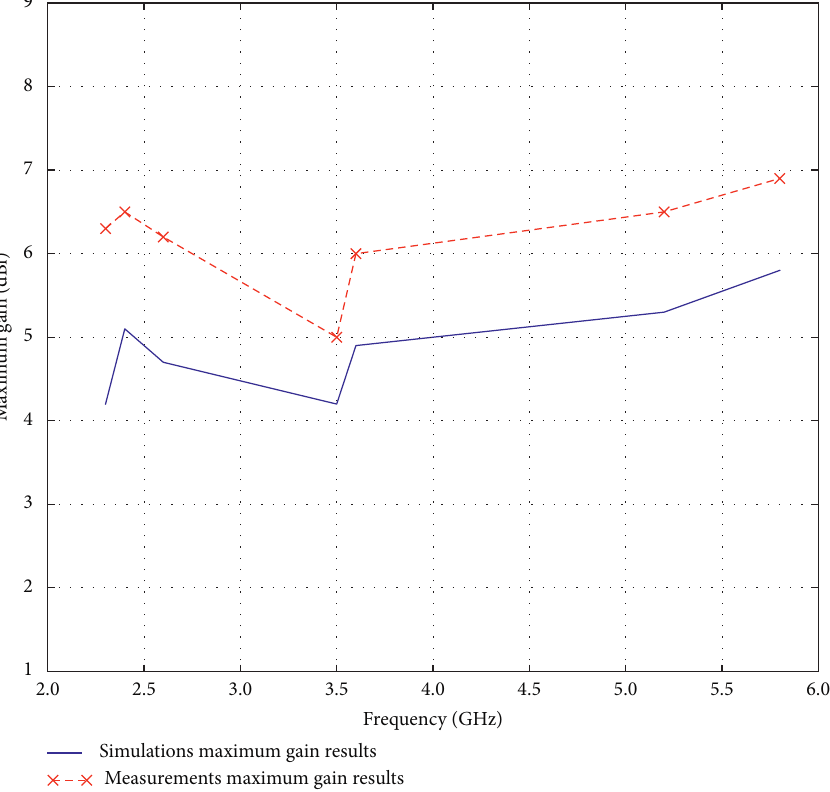
Figure 10: Variation of the maximum gain over frequencies.